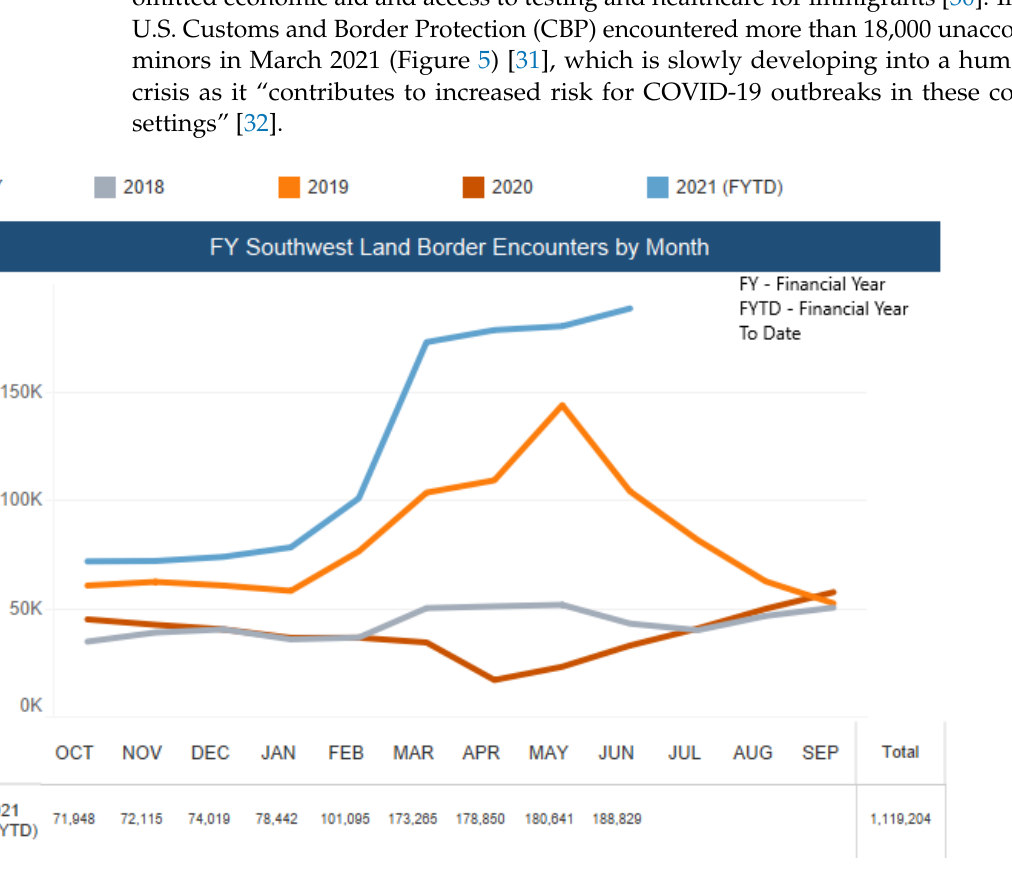
Figure 6. COVID-19 Weekly Cases per 100,000 Population by Race/Ethnicity, United States between 1 March 2020 and 1 May 2021 (Source: Reproduced from the CDC) [4].